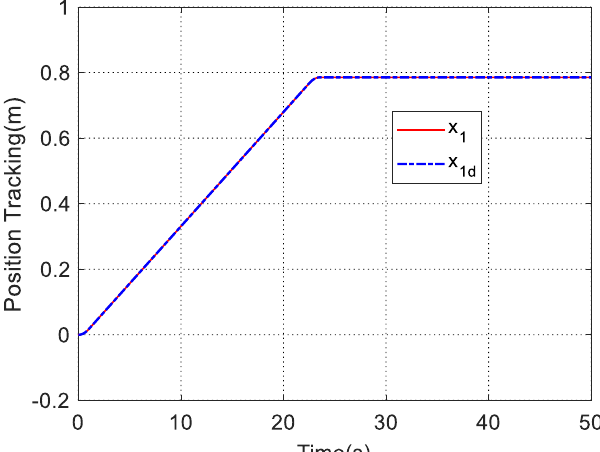
Figure 8. Tracking result of FOFA.